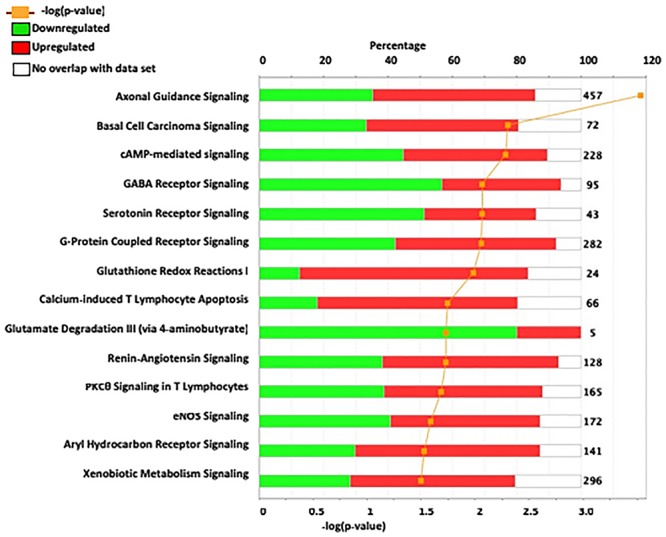
In depth analysis of DEG between ISCS-B and iP using IPA. The most significant IPA canonical pathways are listed on the left. The stacked bar chart reveals the percentage of up-regulated (red) and down-regulated (green) genes within each canonical pathway. The numerical value at the right of each bar represents the total number of genes in the canonical pathways. The secondary x-axis (bottom) represents the -log of p-value.